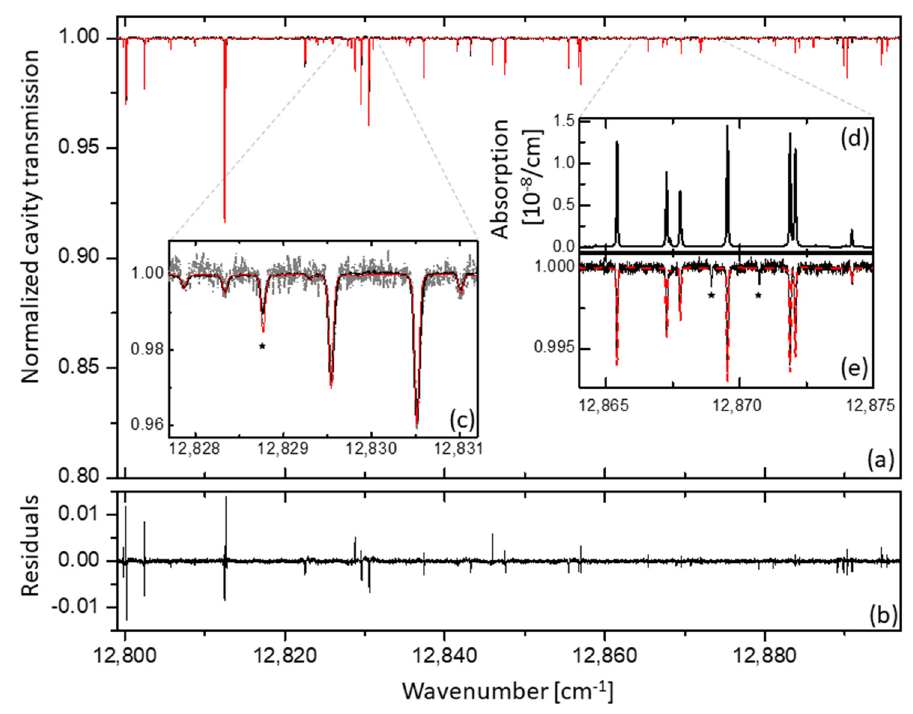
Figure 8. ( a ) Normalized cavity transmission spectrum (black curve, 2000 averages) and the corre- sponding fit of water spectrum (red curve). ( b ) Residuals of the fit. ( c ) Zoom of panel ( a ) showing the spectrum averaged 2000 times (black curve) and averaged 10 times (grey dashed curve) together with the fit to demonstrate the coherent averaging. ( d ) Absorption coefficient corresponding to the spectrum shown in panel ( e ). ( e ) Zoom of panel ( a ) where weak water lines are observed. The lines marked with black stars in panels ( c , e ) are discussed in the text.